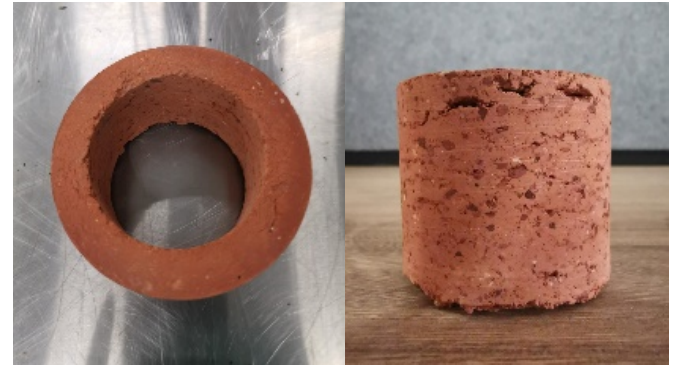
Figure 1. The core of the brick extracted for CHNS analysis.